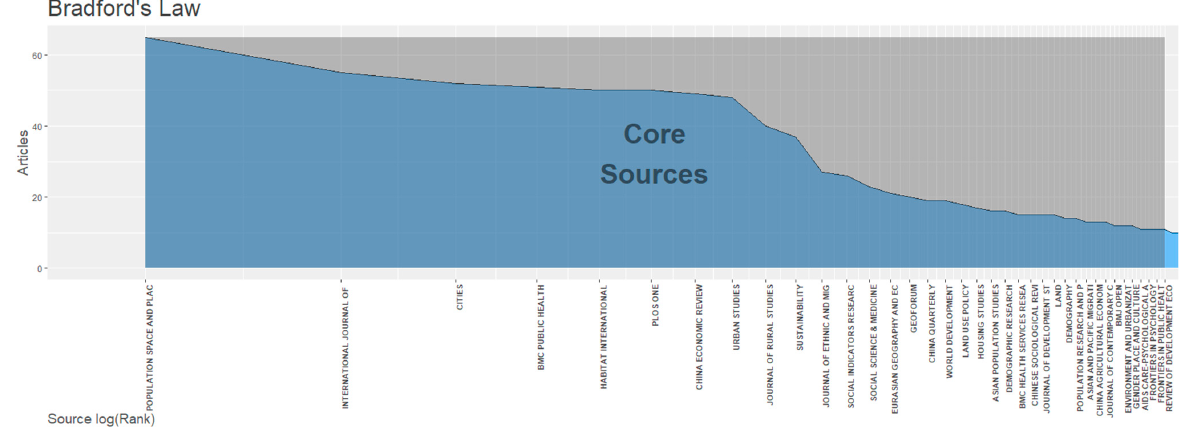
Figure 3. Core sources on the topic of rural-to-urban migrants (1 January 2004–3 June 2022). The top 10 high-yield journals from Zone 1 are listed in Table 2, accounting for 17.8% Table 2. Top 10 journals with the most articles published on the topic of rural-to-urban migrants of the total number of publications and 22% of the total citations. These are primarily (1 January 2004–3 June